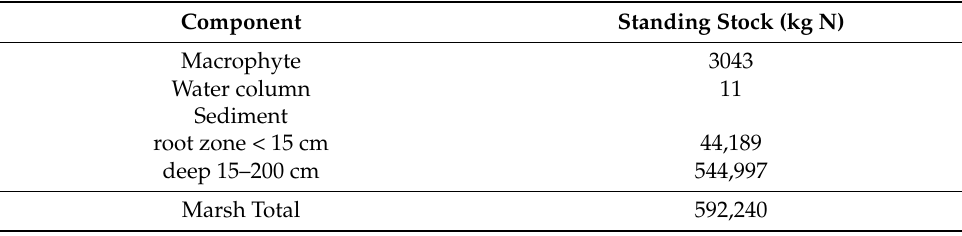
Table 2. Estimates of N standing stocks in Cell